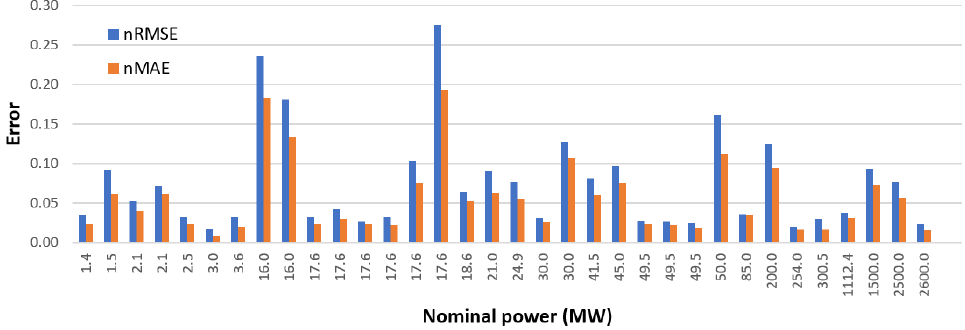
Figure 19. Magnitude of error depending on rated power of the system.